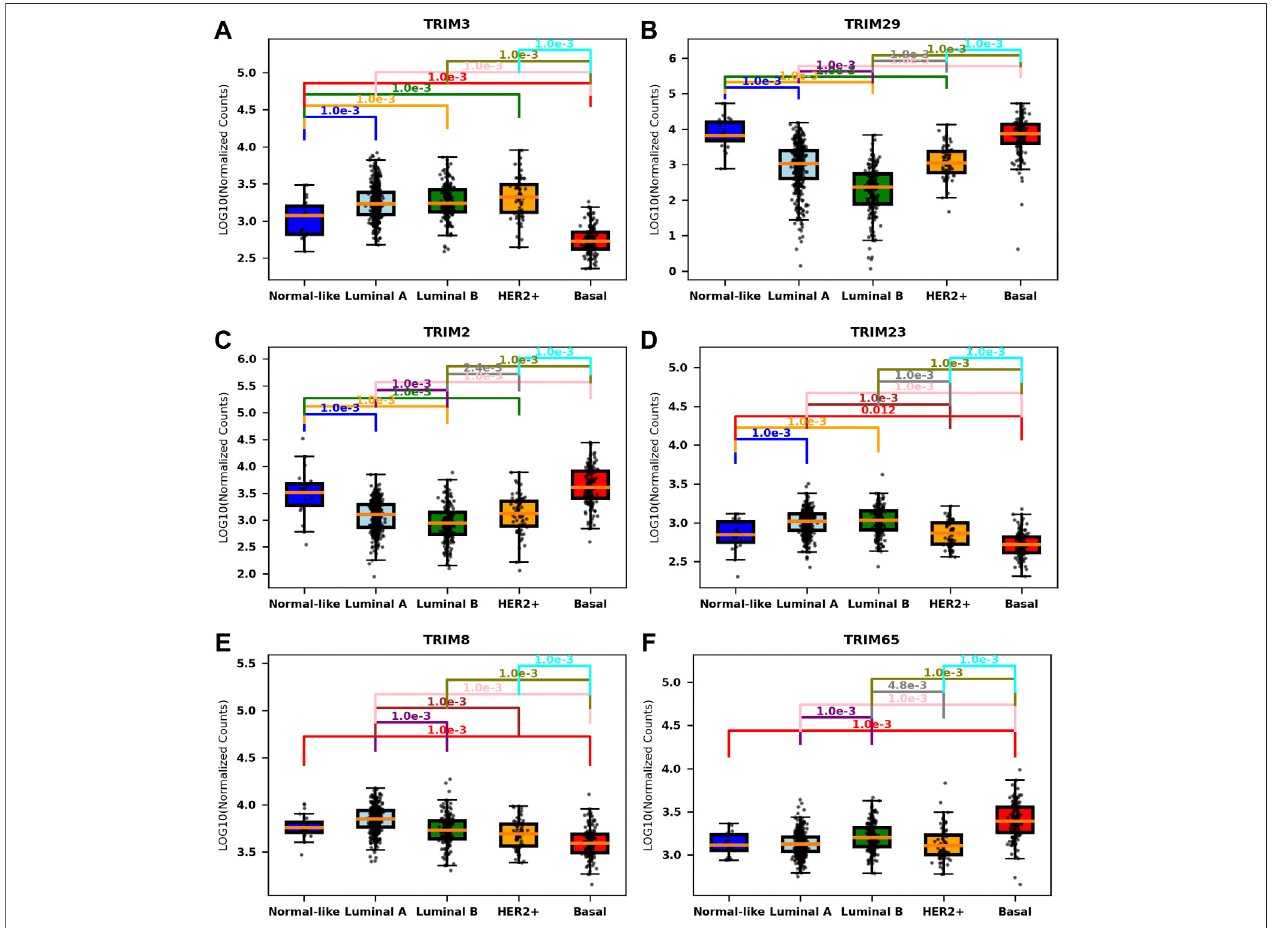
FIGURE 2 | Association of TIRMs ’ expression and molecular subtypes in BC. Boxplots of the expressions of the most signi fi cant TRIMs in different molecular subtypes. (A) TRIM3 , expressed signi fi cantly lower in the normal-like and basal subtypes. (B) TRIM29 , expressed signi fi cantly higher in the normal-like and basal subtypes. (C) TRIM2 , expressed signi fi cantly higher in the normal-like and basal subtypes. (D) TRIM23 , expressed signi fi cantly lower in the basal subtype. (E) TRIM8 , expressed signi fi cantly lower in the basal subtype. (F) TRIM65 , expressed signi fi cantly higher in the basal subtype.